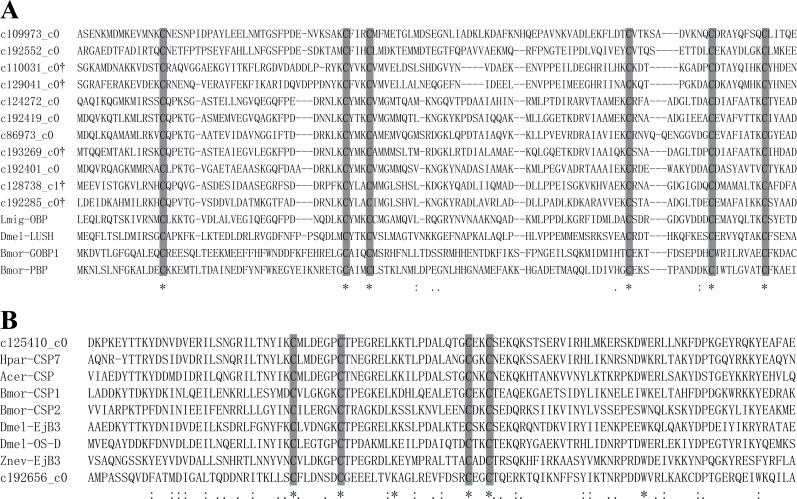
Alignment of the partial amino acid sequence of Coptotermes formosanus OBPs and CSPs with that from other insects.Grey boxes show conserved cysteines. (A) Alignment of eleven C. formosanus putative classical OBPs with other insects. The symbol † represent DEGs. (B) Alignment of two C. formosanus putative CSPs with other insects.